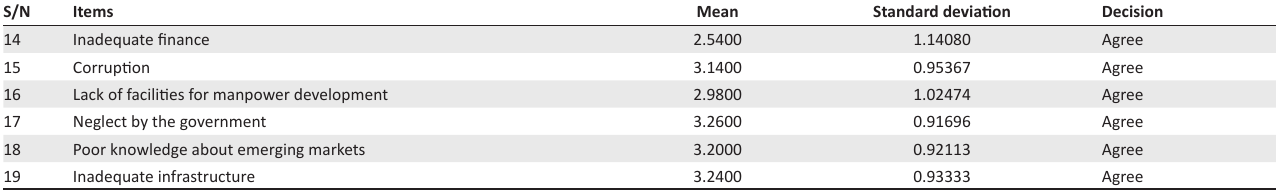
TABLE 4: Challenges of rural entrepreneurship. S/N